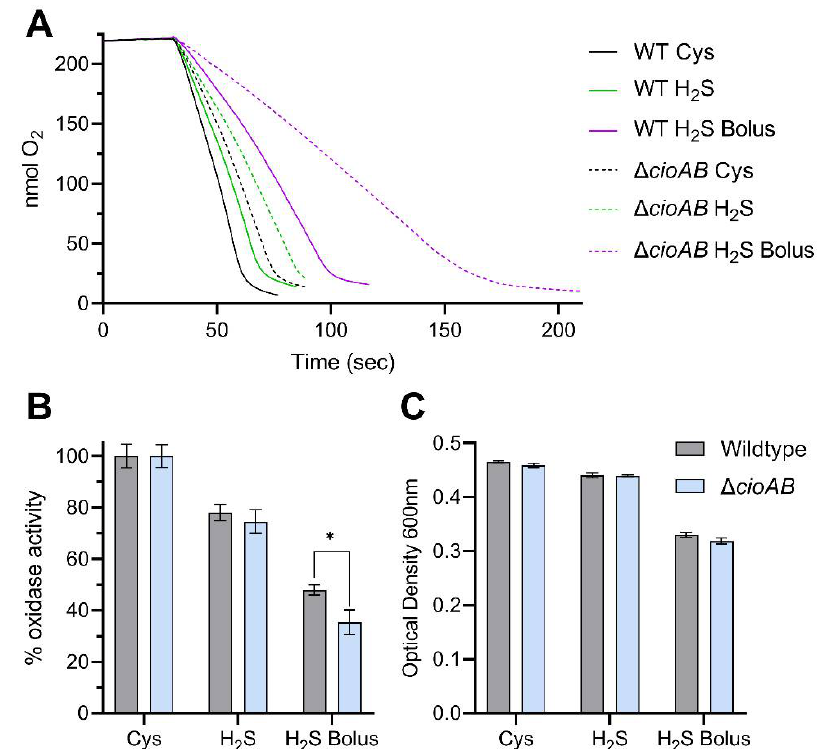
Figure 7. Inactivation of terminal oxidase activity by sulfide. ( A ) Total oxidase activity of wildtype and cioAB mutant with sodium formate as electron donor, measured in a Clark-type oxygen electrode. Cells were grown with either L-Cysteine or sulfide as sole sulfur source. Sulfide was added either progressively throughout the growth curve or by bolus addition at the start (0.1 mM final). ( B ) Total oxidase activity of the above samples, displayed as percentage activity relative to the L-Cysteine control. * p < 0.05. ( C ) Growth of the above samples, displayed as the optical density reached after 4 h of growth.